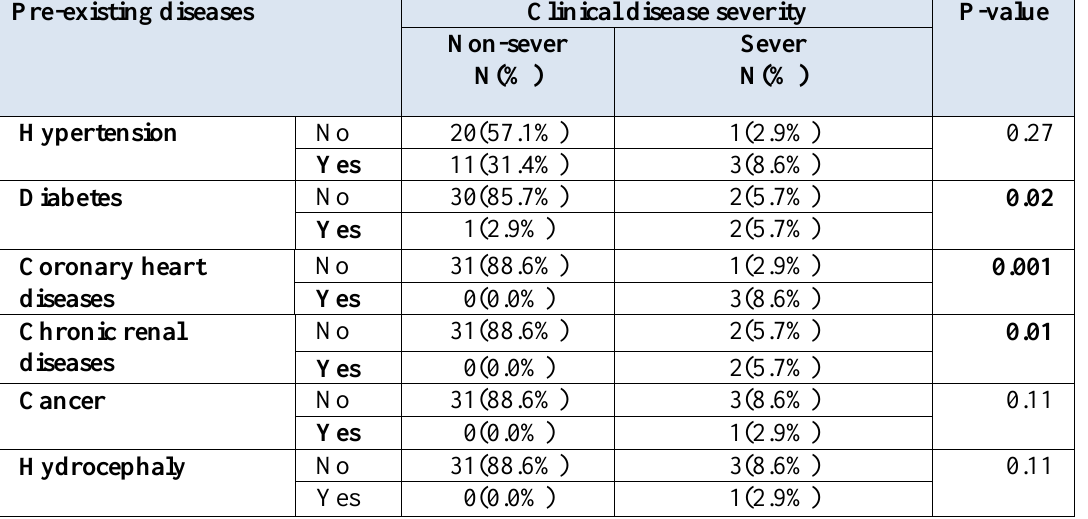
Table 3: Association between pre-existing chronic diseases and severity of COVID-19. Pre-existing